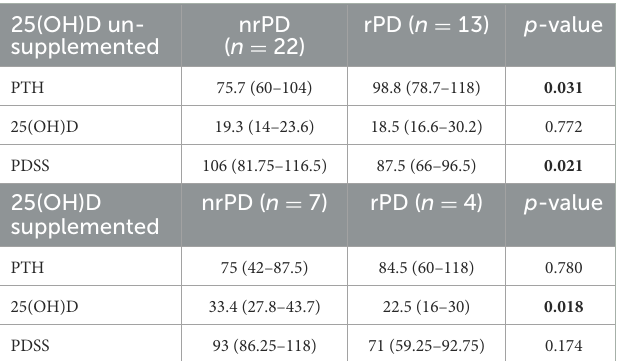
TABLE 3 Prevalence of leg restlessness in patients with or without 25(OH)D